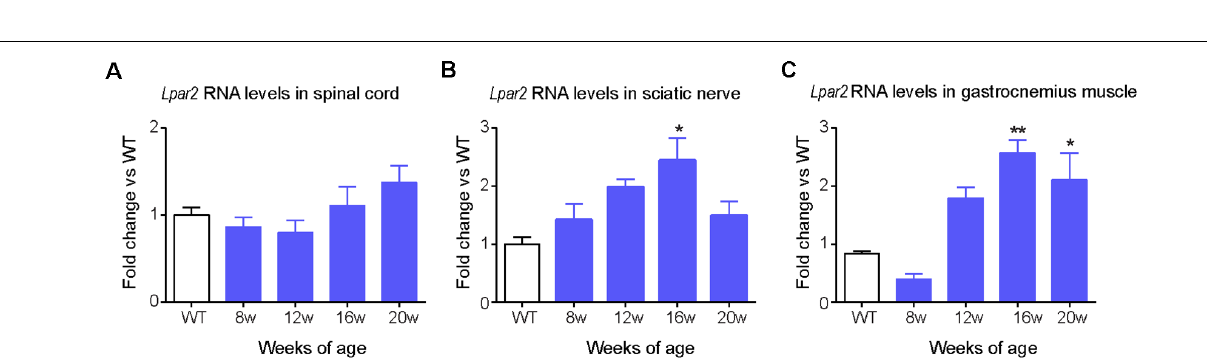
FIGURE 2 | Dynamic changes in Lpa 2 expression in SOD1 G93A mice. (A–C) Graphs showing the changes in Lpar2 RNA levels in the spinal cord (A) , sciatic nerve (B) , and gastrocnemius muscle (C) of SOD1 G93A at 8, 12, 16, and 20 weeks of age relative to wild-type littermate mice. (A) n = 5 per group and time point. One-way ANOVA with Bonferroni’s post hoc test. * p < 0.05, ** p < 0.01 vs. WT mice. Data are shown as mean ±